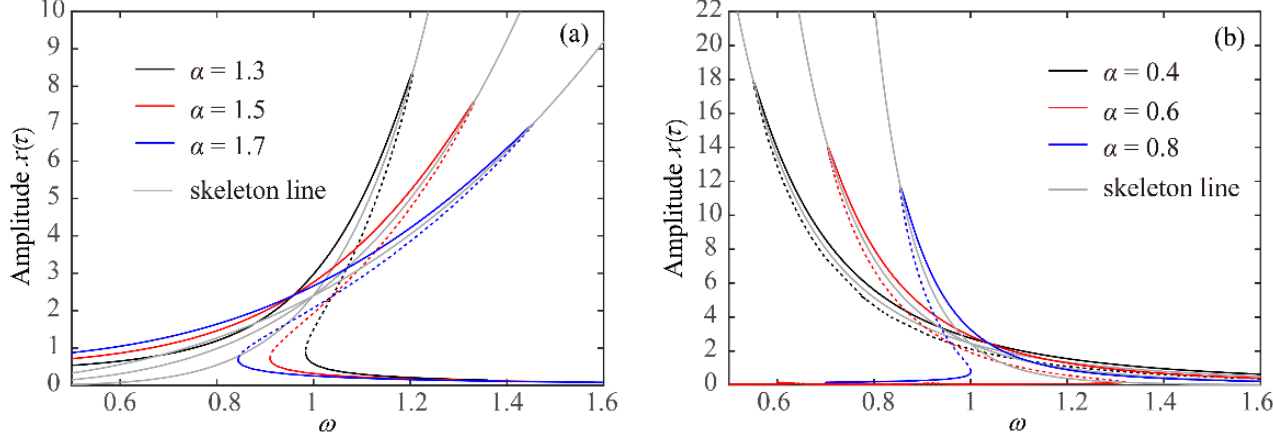
Figure 3. For W = 0, influence of α on the frequency-response peak-to-peak curves of continuous system, ( a ) α > 1 and ( b ) 0 < α < 1.